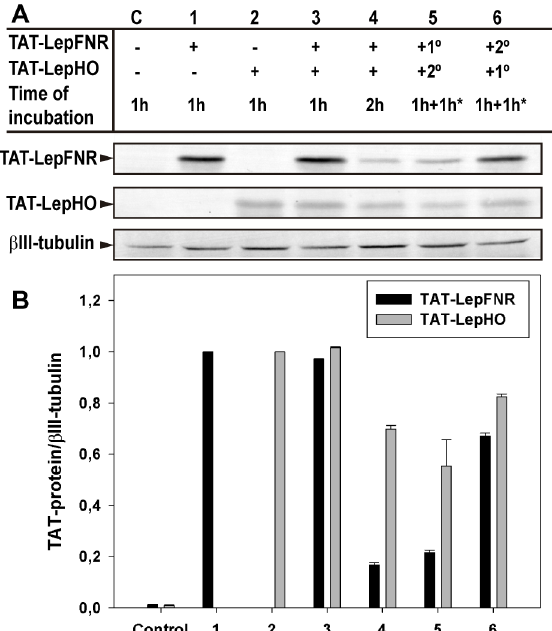
Fig 7. TAT-LepFNR and TAT-LepHO simultaneous transduction. (A) SH-SY5Y cells were incubatedwith each TAT-protein or both, as depicted, and cell extracts were preparedand examinedby Western blot analysis. * The incubationswere done sequentially in the indicatedorder. As a control (C), cells were incubatedfor 1 h with 1 μ M Lep-FNR/Lep-HO (C). Representative blots of 3 different experiments are shown. (B) Densitometric analysisof the transduced proteins. Protein levels were normalizedto that of β III-tubulin.